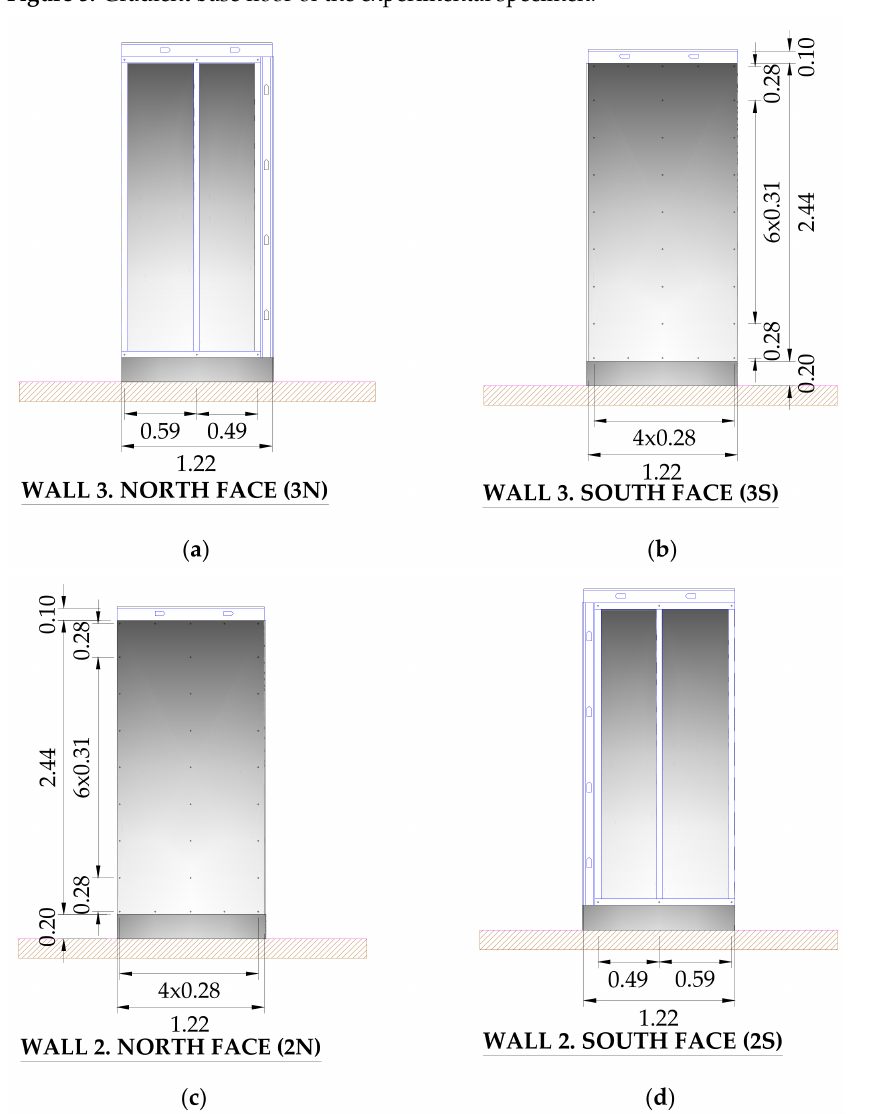
Figure 6. Covered base floor of the ceiling of the experimental specimen in full-scale: ( a ) North face of wall 3; ( b ) South face of wall 3; ( c ) North face of wall 2; ( d ) South face of wall